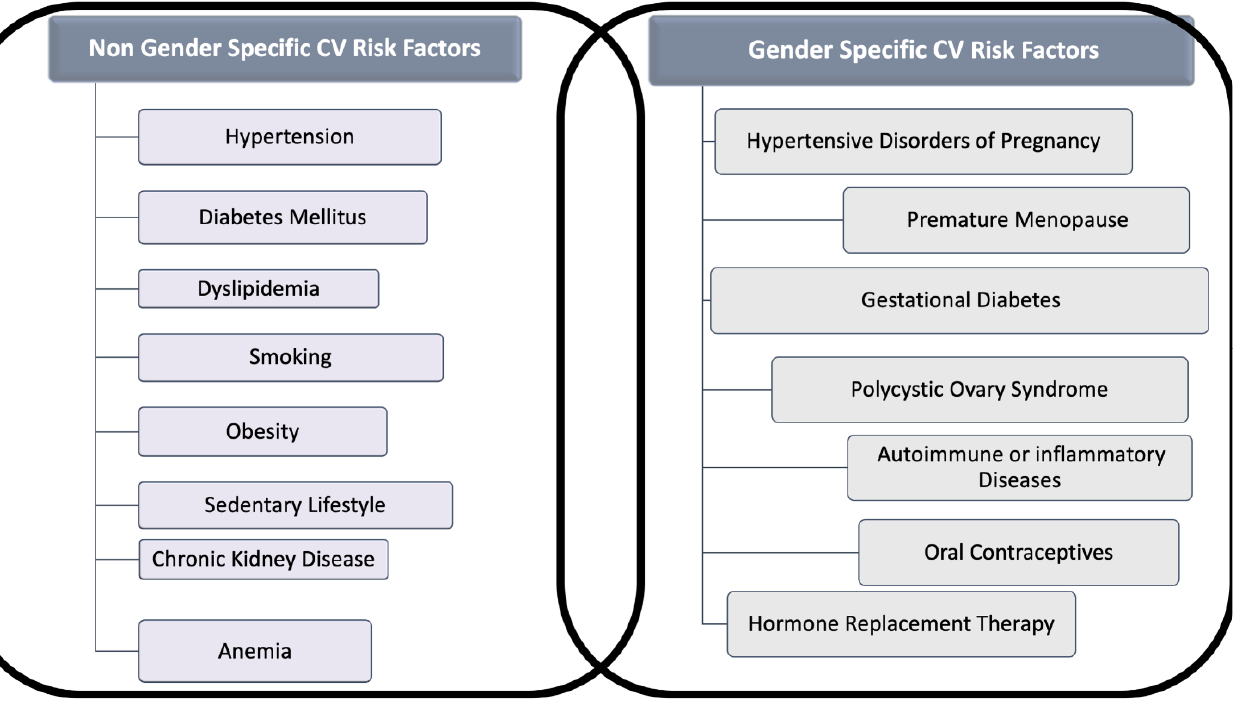
Figure 1. Gender and Non-Gender Cardiovascular (CV) Risk factors for cardiovascular disease in women. The figure distinguishes risk factors for cardiovascular disease in two categories: (A) Those that are related to gender, often under-recognized and (B) those that interest both sexes, but which might act in women differently than in men.